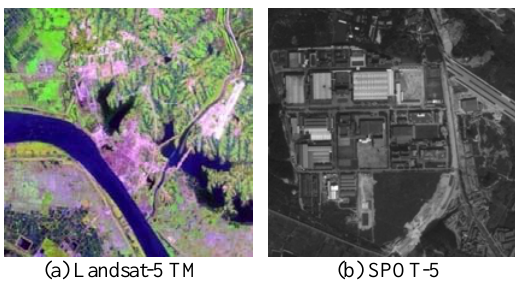
Figure 2. Testing images for differential